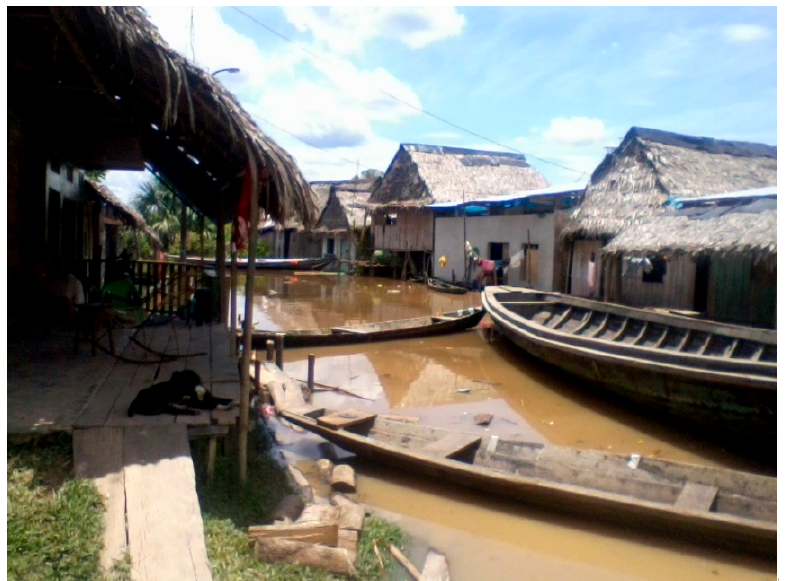
Figure 1. A flooded street in Santa Clara de Nanay, April 2, 2012 (courtesy of Asociación Benéfica Prisma).